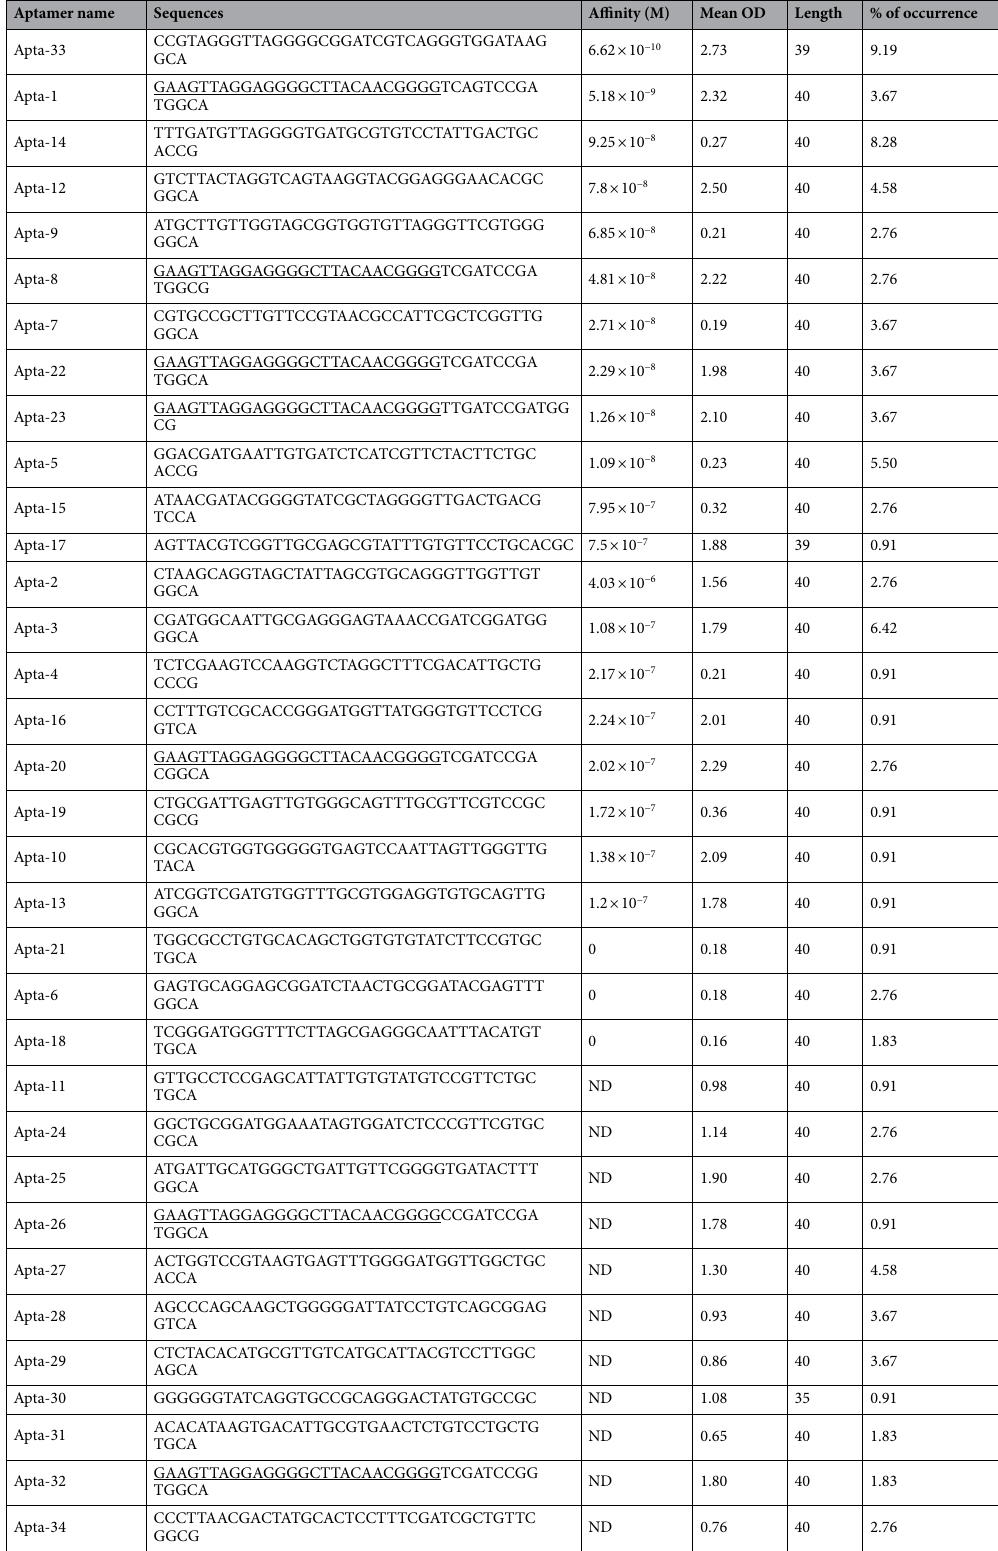
Table 1. List of aptamers, their sequences, K D values and % of occurrence. The repeated regions are underlined. The mean OD for each aptamer in the initial evaluation of aptamers in the Aptamer–Antibody sandwich was demonstrated in Mean OD